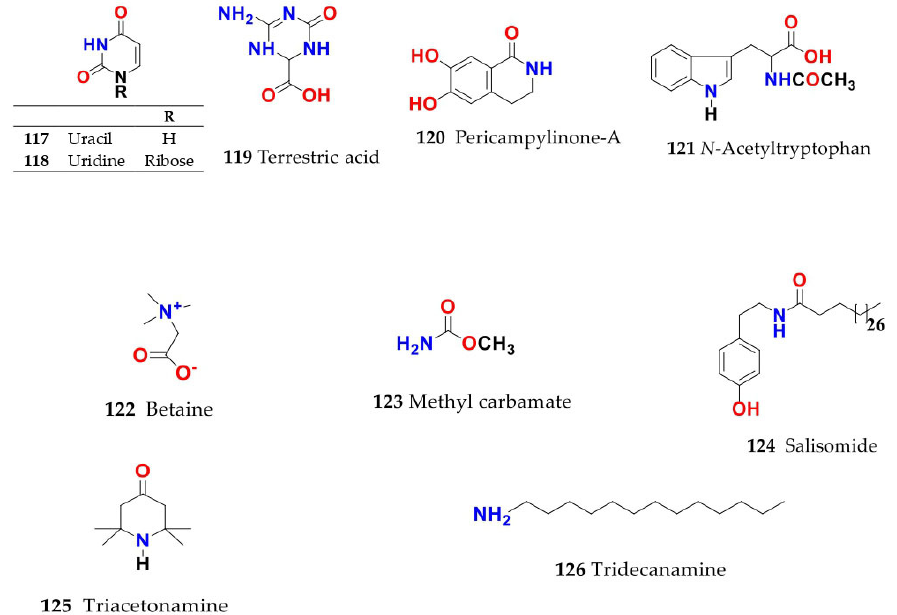
Figure 9. Chemical structure of nitrogenous compounds ( 117 – 126 ) isolated from genus Salsola.